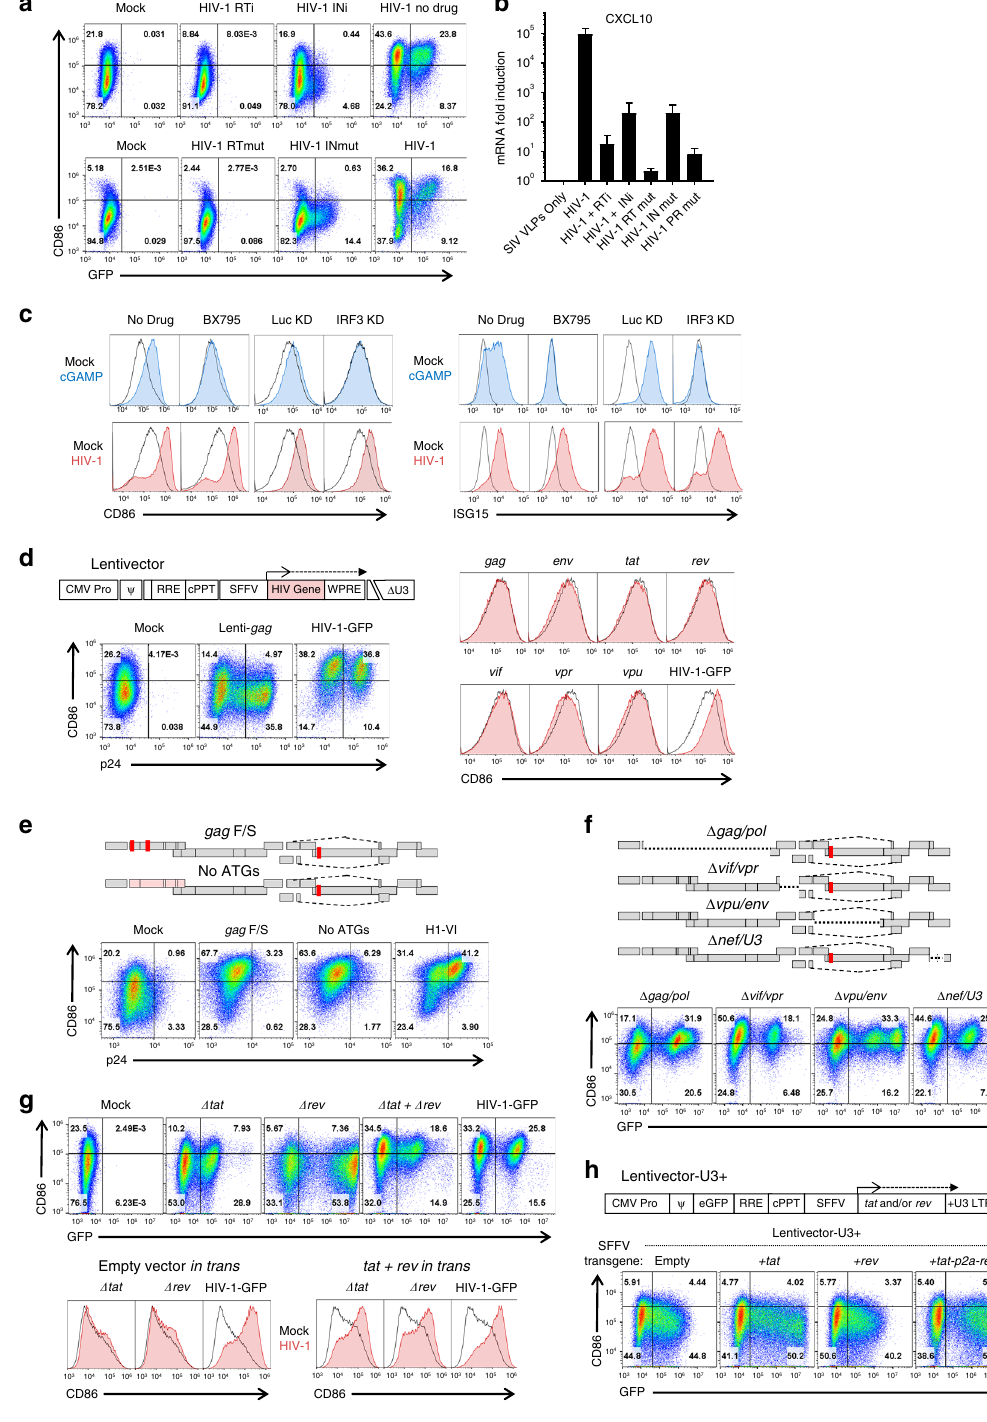
mechanism of innate immune activation was similar to that in DCs. As with DCs, HIV-1-GFP bearing the Δ gag/pol deletion activated macrophages and CD4 + T cells (Fig. 4b and Supple- mentary Fig. 4a, d). Also in agreement with the DC results, neither the minimal lentivector, nor HIV-1-GFP bearing mutations in integrase , tat , or rev , matured any of the three cell types (Fig. 4b and Supplementary Fig. 4a, d). CD4 + T cells were infected with either macrophage-tropic or T